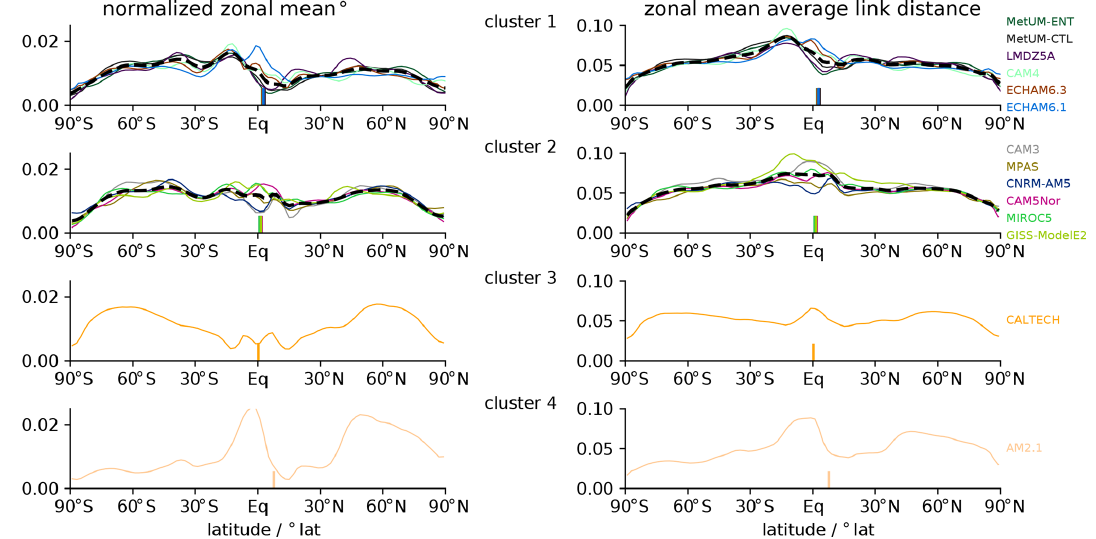
Figure 4. Zonal-mean network measures from the global networks of the AquaControl simulations for each of the four clusters. The left panels show the normalized zonal-mean degree, and the right panels show the corresponding average link distance patterns. Vertical lines indicate the position of the ITCZ. The cluster mean is shown by black dashed